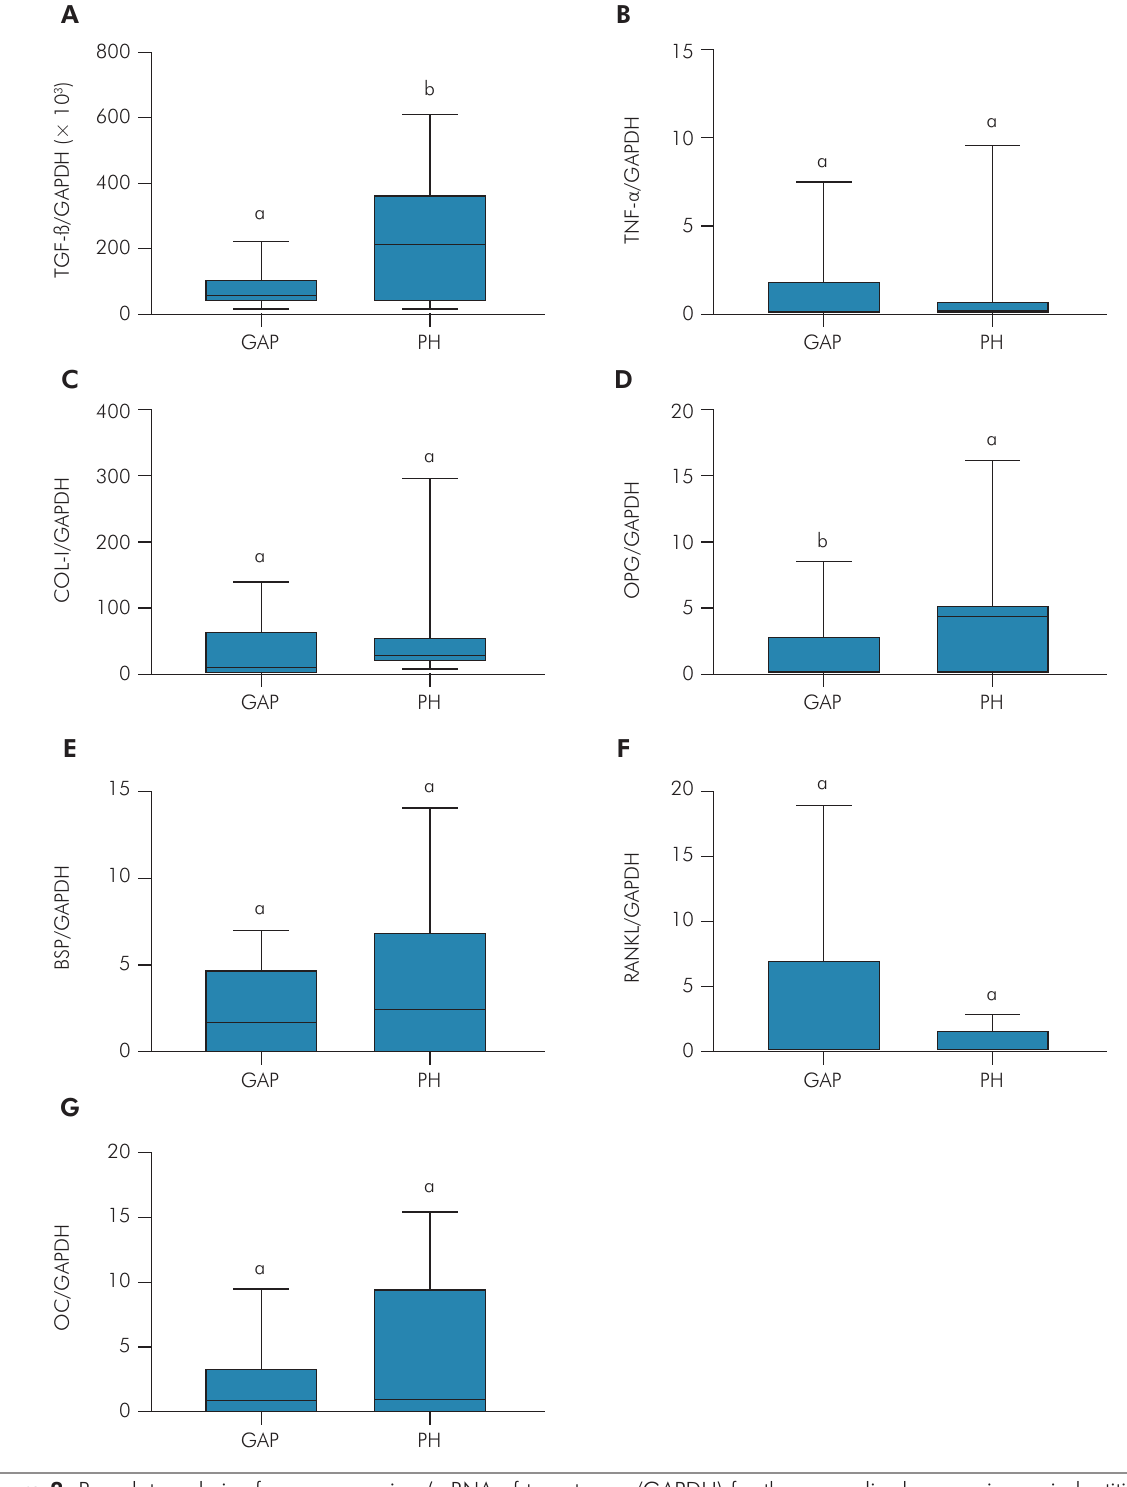
Figure 2. Box plot analysis of gene expression (mRNA of target gene/GAPDH) for the generalized aggressive periodontitis and periodontally healthy groups. Different letters indicate significant differences between groups (Mann-Whitney test; p < 0.05). (A) Transforming growth factor (TGF)- β ; (B) Tumor necrosis factor (TNF)- α ; (C) Type I collagen (COL I); (D) Osteoprotegerin (OPG); (E) Bone sialoprotein (BSP); (F) Receptor activator of the NF- κ B ligand (RANKL); (G) Osteocalcin (OC), glyceraldehyde-3-phosphate dehydrogenase